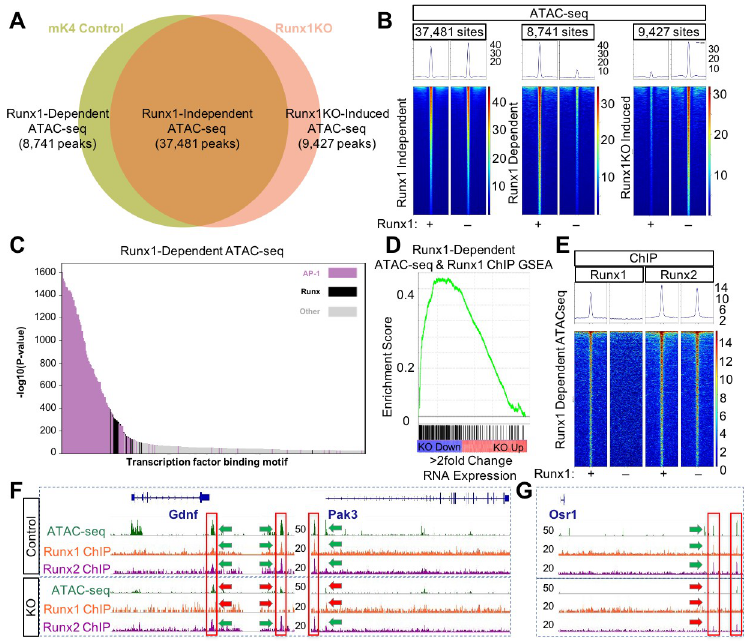
Fig 3. Runx1 Deletion Alters Chromatin Accessibility Despite the Presence of Runx2. A) Venn diagram of ATAC- seq peaks in control and Runx1KO cells showing the number of regions open in both cell lines (Runx1-independent), regions open only in control cells (Runx1-dependent) and regions open only in Runx1KO cells (Runx1KO-induced). B) Heatmaps of the ATAC-seq reads mapping to Runx1-independent, Runx1-dependent, and Runx1KO-induced peaks in the control and Runx1KO cells. C) Graph of the -log10 p-values of motif enrichment, displaying that Runx1-dependent ATAC-seq peaks are strongly enriched for AP-1 and Runx motifs. D) Gene set enrichment analysis showing enrichment of transcriptionally down-regulated genes (in blue and up-regulated in red) by Runx1-dependent ATAC-seq peaks that are bound by Runx1. E) Heatmap showing Runx1-Dependent ATAC-seq regions bound in Runx1 and Runx2 ChIP experiments. F) Genomic snapshots of Gdnf and Pak3 genes that are downregulated in Runx1KO cells showing open chromatin regions present in control cells but not Runx1KO cells that are bound by Runx1 and Runx2 and retain Runx2 binding in the Runx1KO cells. G) Genomic snapshot of the Runx1KO downregulated gene Osr1 that has genomic regions that lose chromatin accessibility in Runx1KO cells, which